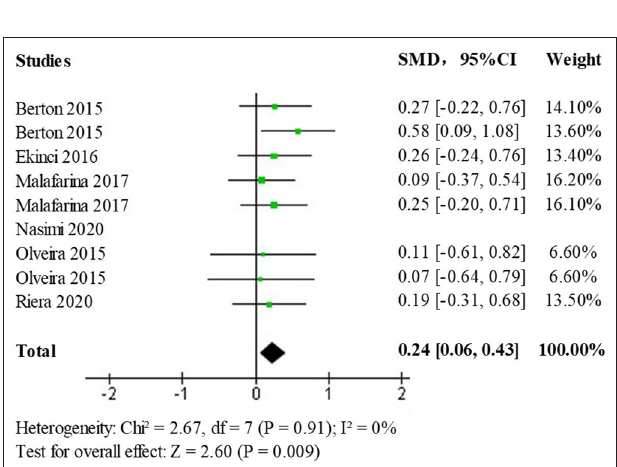
FIGURE 7 | Forest plot of the effect of HMB on lower limb muscle strength in the elderly population.